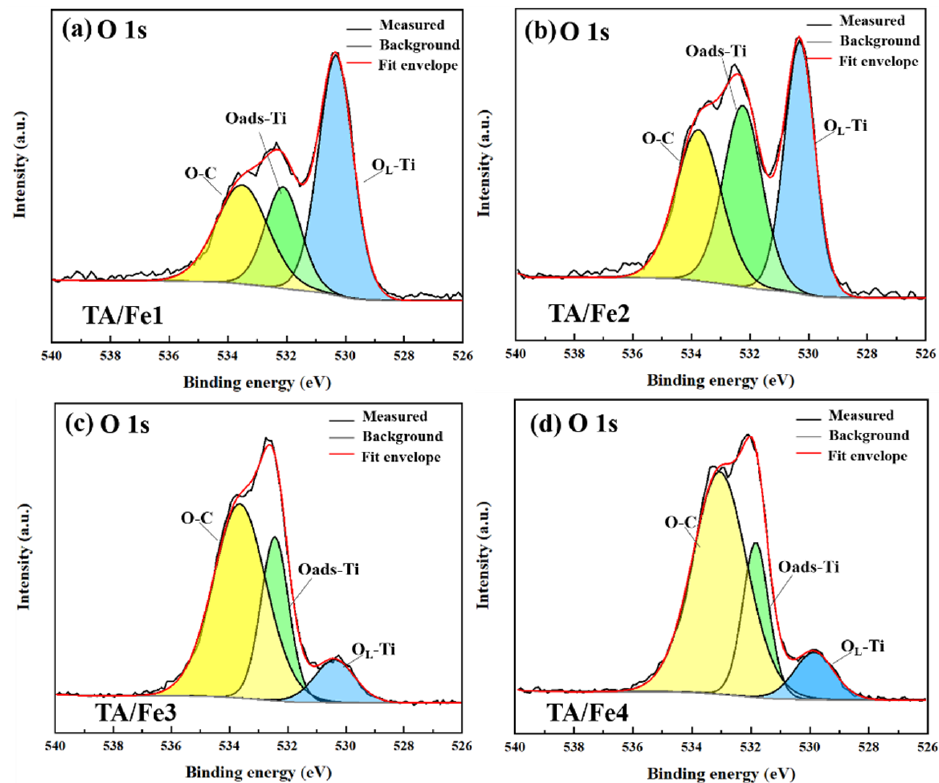
Figure 6. Ti 2p XPS spectra of the titanium oxide ‐ based aerogel catalysts doped by different Fe